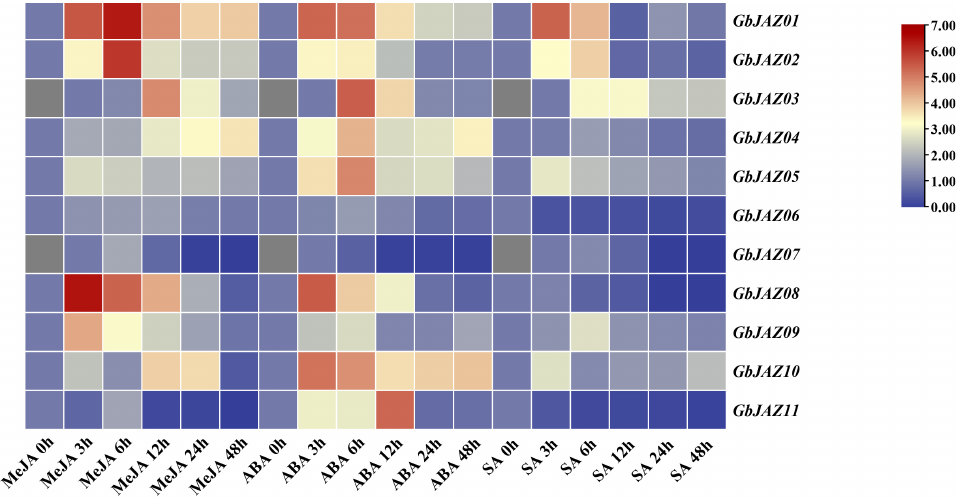
Figure 8. Heatmap analysis of GbJAZ expression levels under the induction of MeJA, ABA and SA.